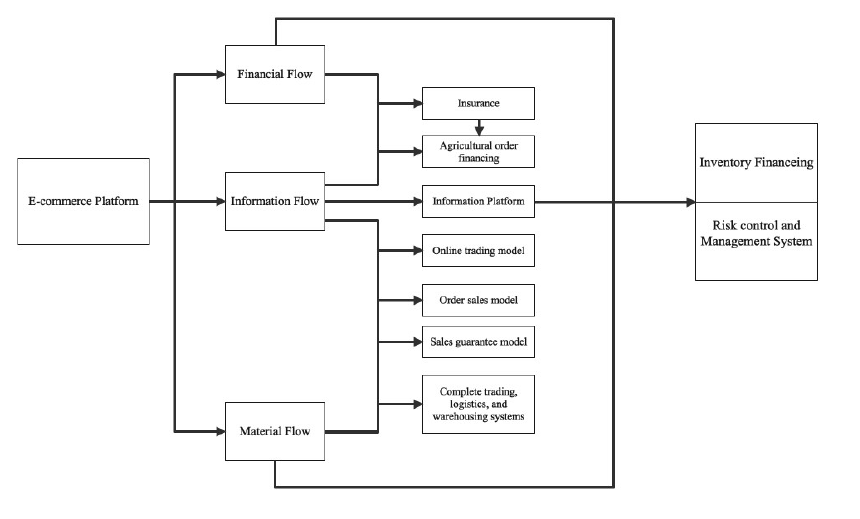
Figure 4. Research Roadmap. Table 3. The current situation of the traditional agricultural model and the problems faced by